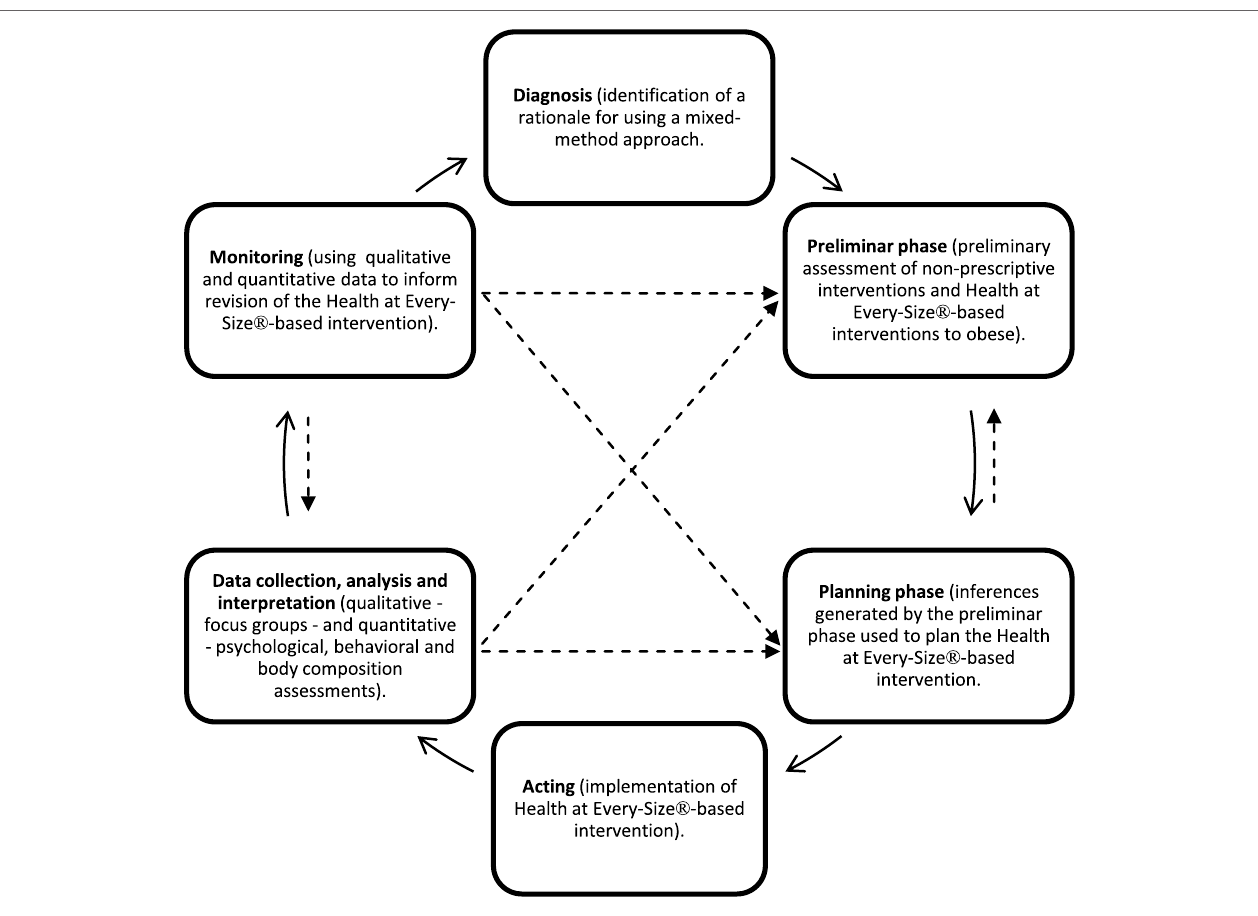
FigUre 1 | illustration of the conceptual framework